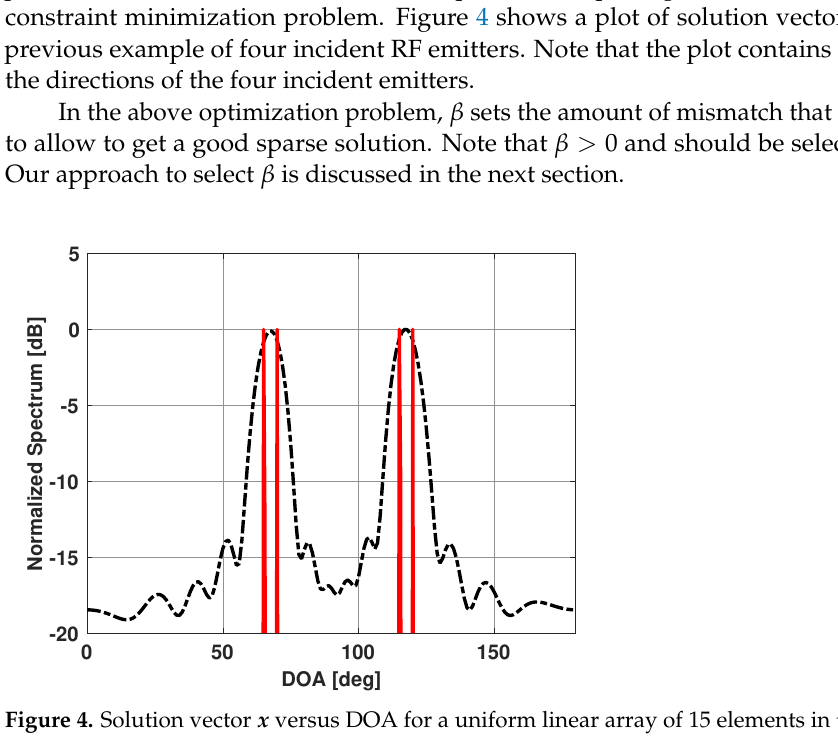
Figure 4. Solution vector x versus DOA for a uniform linear array of 15 elements in the presence of four signals at 65 ◦ , 70 ◦ , 115 ◦ , and 120 ◦